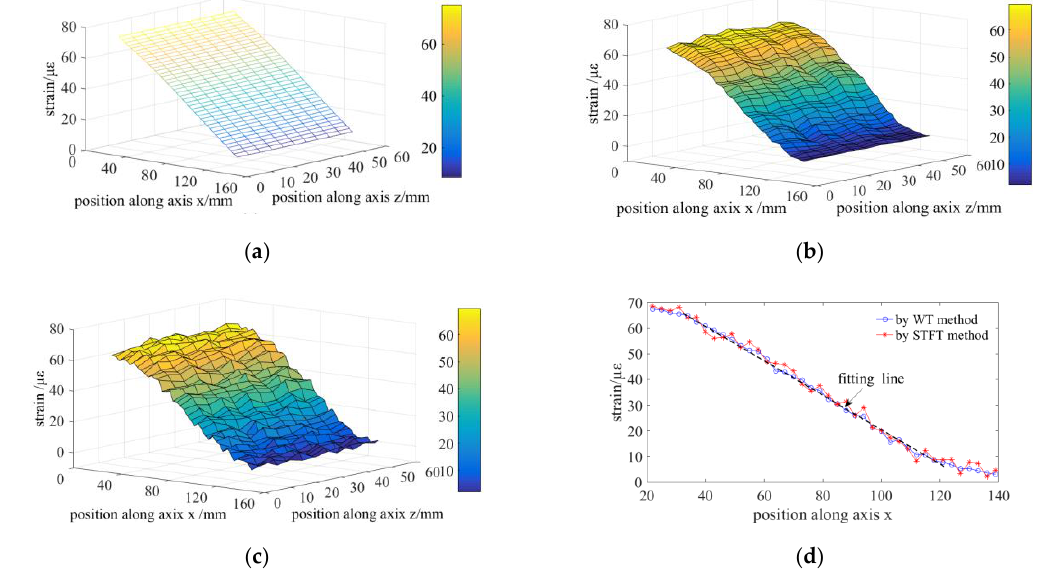
Figure 11. Experiment on sensing the distributed strain on the surface of an Aluminum alloy plain: ( a ) simulation result; ( b ) measured result by WT method; ( c ) measured result by STFT method; and, ( d ) comparison of the distributed strain curve along axis z located at 25 mm achieved by WT and STFT method.